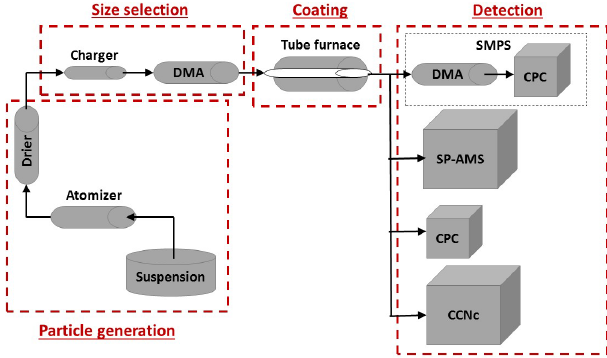
Figure 1. Schematic of the experimental setup, including particle generation using an atomizer and a drier, size selection with a dif- ferential mobility analyzer (DMA), coating and three types of mea- surements: CCN activity measurements using a condensation parti- cle counter (CPC) and a cloud condensation nuclei counter (CCNc), size distribution measurements by a scanning mobility particle sizer (SMPS) and particle composition analysis by a soot particle aerosol mass spectrometer